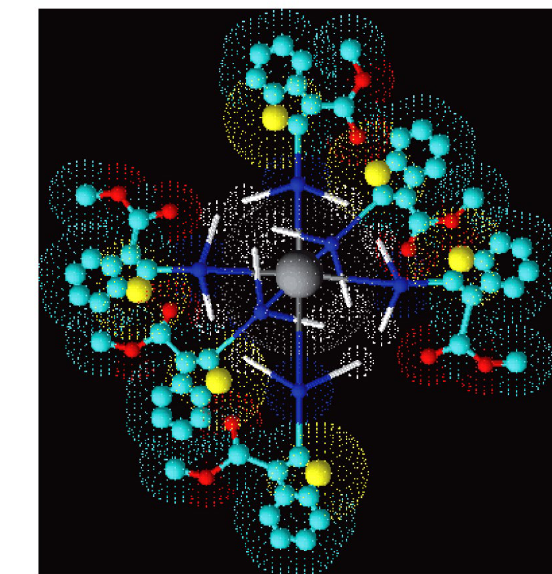
Figure 5. Structural representation of complex 4